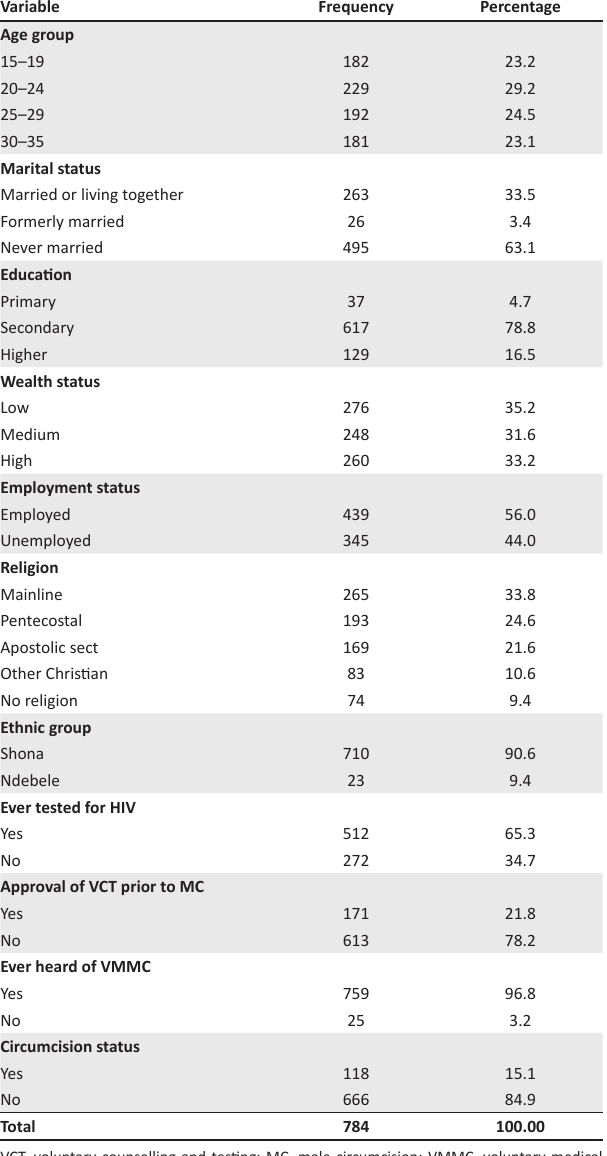
TABLE 1: Background characteristics of the study respondents ( n = 784).